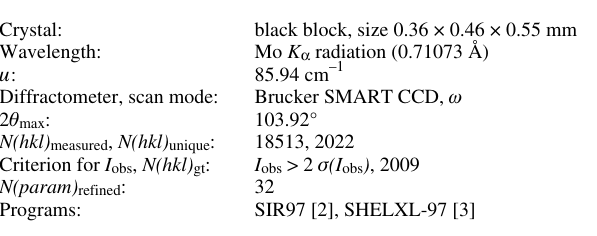
Table 1. Data collection and handling.